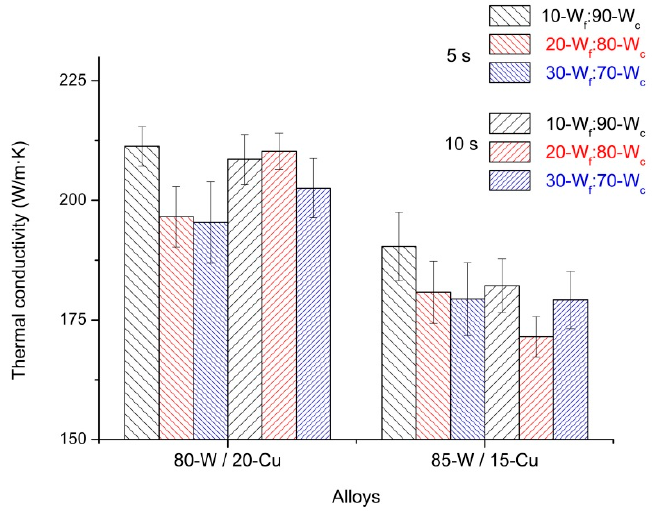
Figure 10. Thermal conductivity of the specimens produced from the three bimodal powders hot consolidated for 90 s.